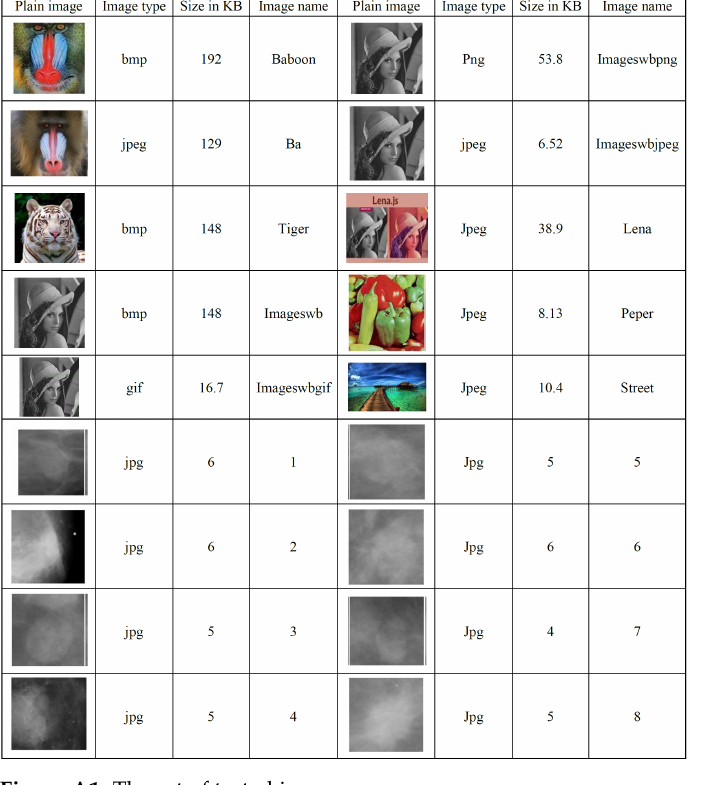
Figure A1. The set of tested